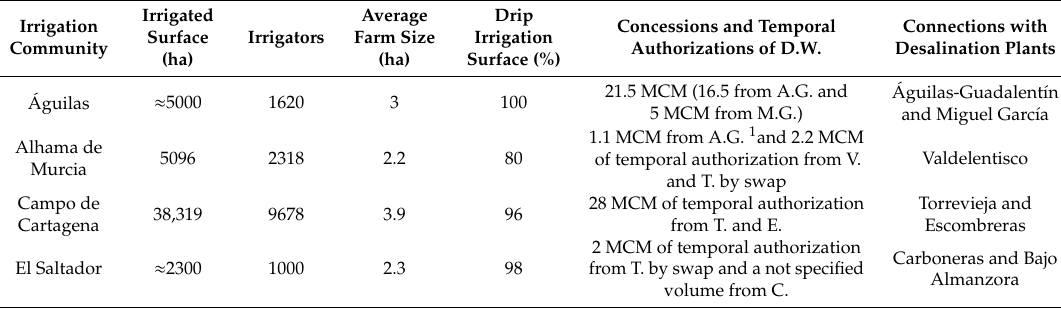
Table 1. Irrigation community’s